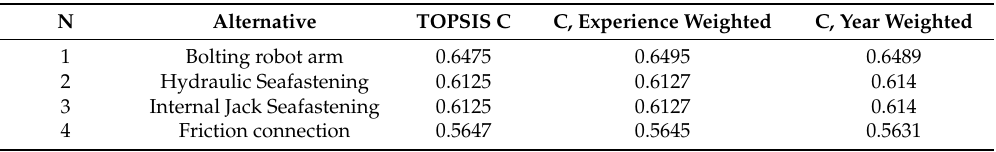
Table 8. First stage TOPSIS results for ‘Connections and Seafastening’.